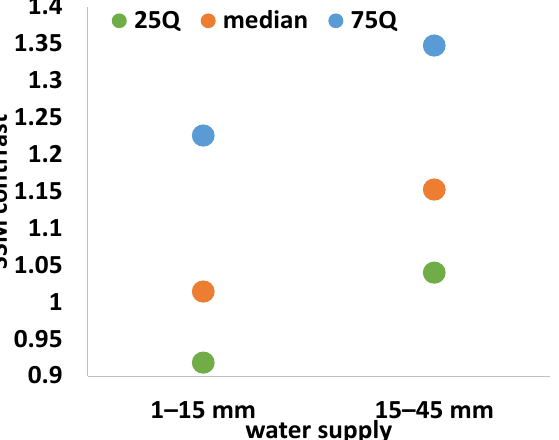
Figure 10. First quartile (25Q, green points), median (orange points) and third quartile (75Q, blue points) of the SSM contrast as a function of water supply in case of TS = 1 of Figure 8.